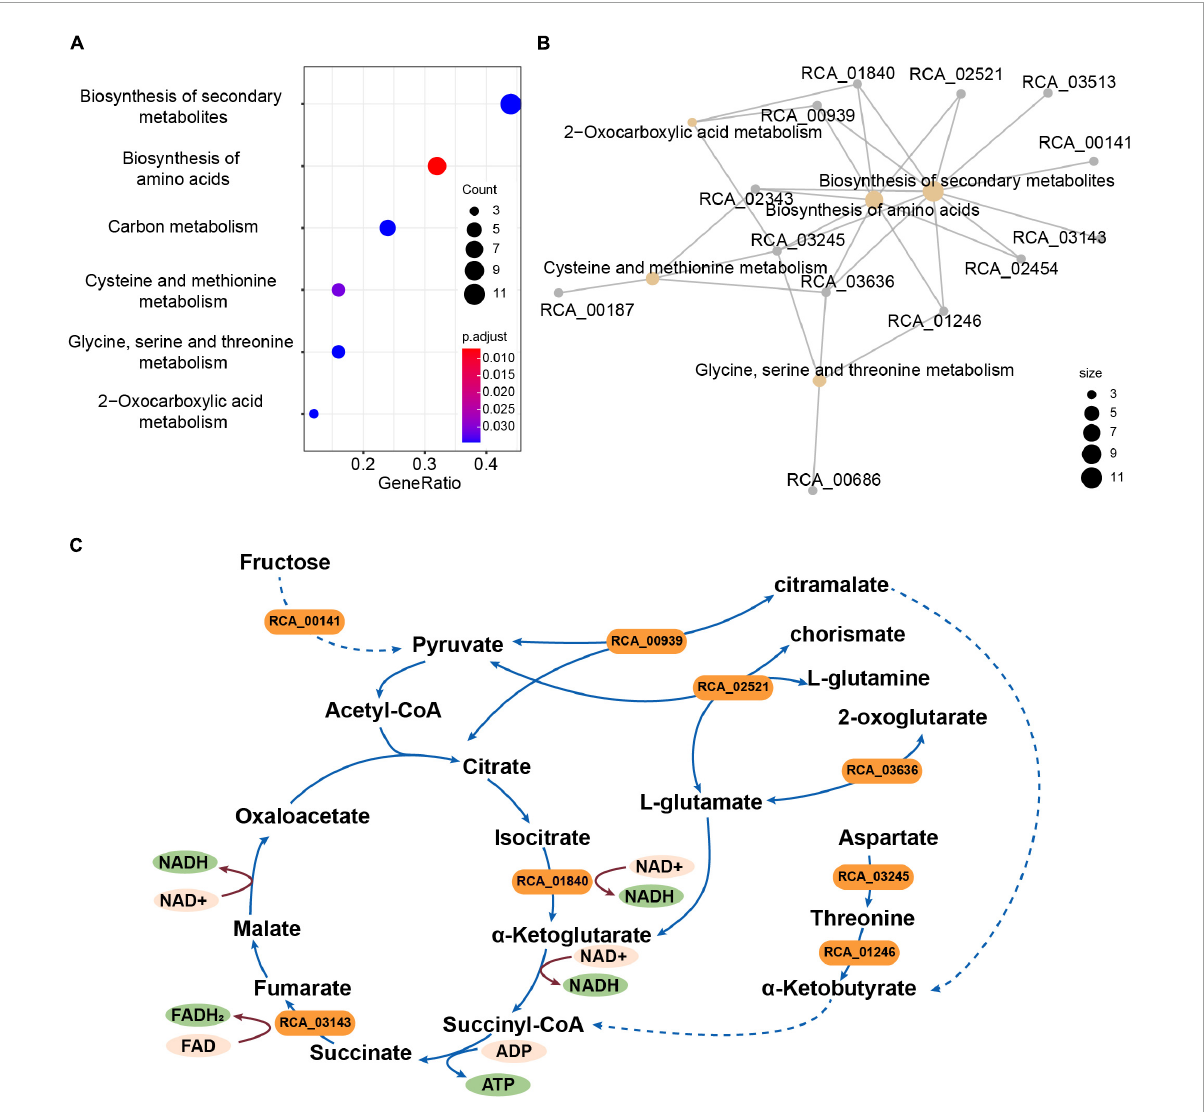
FIGURE4 Genes under positive selection in strain CACMS001 were tightly linked to energy metabolism. (A) Enriched pathways in genes under positive selection, (B) map of genes enriched in the KEGG pathway, and (C) genes in enrichment pathways participating in energy metabolism. Solid lines represent one-step reactions; dashed lines represent multi-step reactions; arrows represent the directions of reactions; and rounded rectangle represent